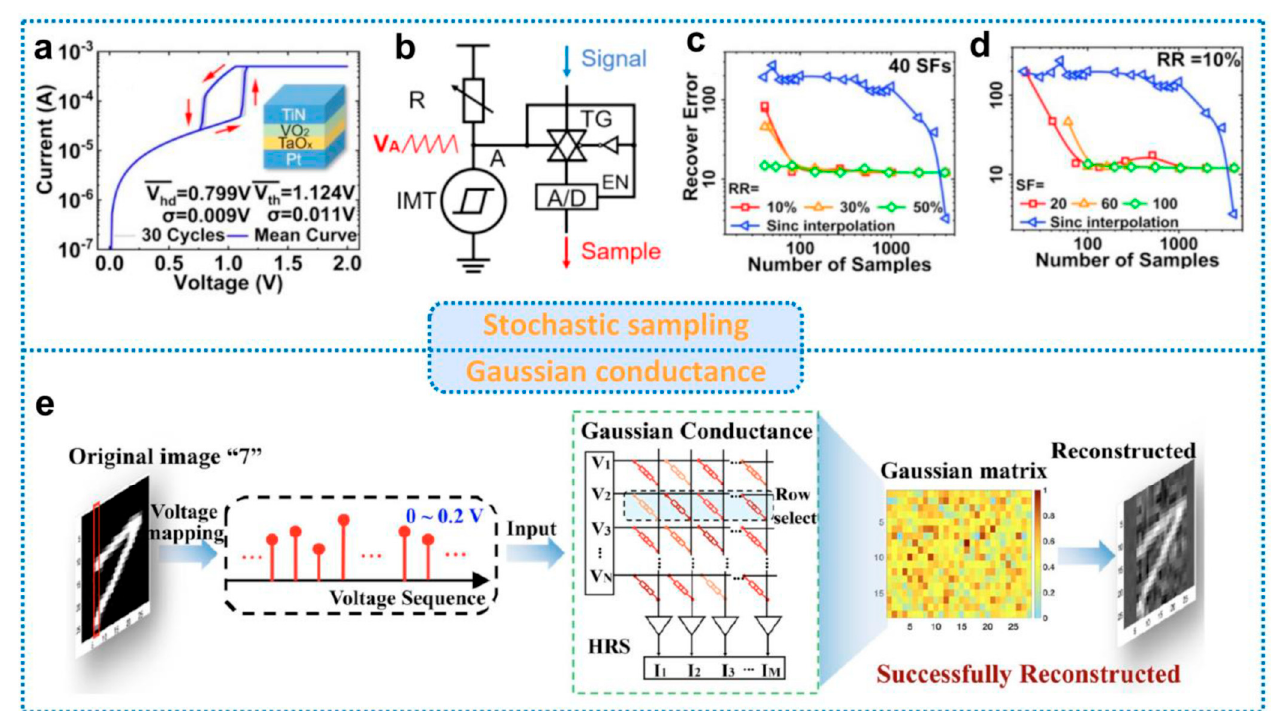
Figure 10. Volatile memristors for compressed sensing. ( a ) The typical I-V curve of VO 2 /TaO x stacking structure. ( b ) Schematic image of the stochastic sampling circuit. ( c , d ) Benchmark of TSO-based compressed sensing paradigm with conventional Nyquist method. Reproduced with permission [90] Copyright 2020, IEEE. ( e ) Gaussian conductance mode for signal compression. The original image “7” was mapped as a 0–0.2 V voltage sequence and applied to an array of devices with a Gaussian conductance distribution. Signal compression coding is accomplished by Kirchhoff’s current law and Ohm’s law. Finally, the OMP algorithm reconstructs the signal. Reproduced with permission [91] Copyright 2023, Wiley −